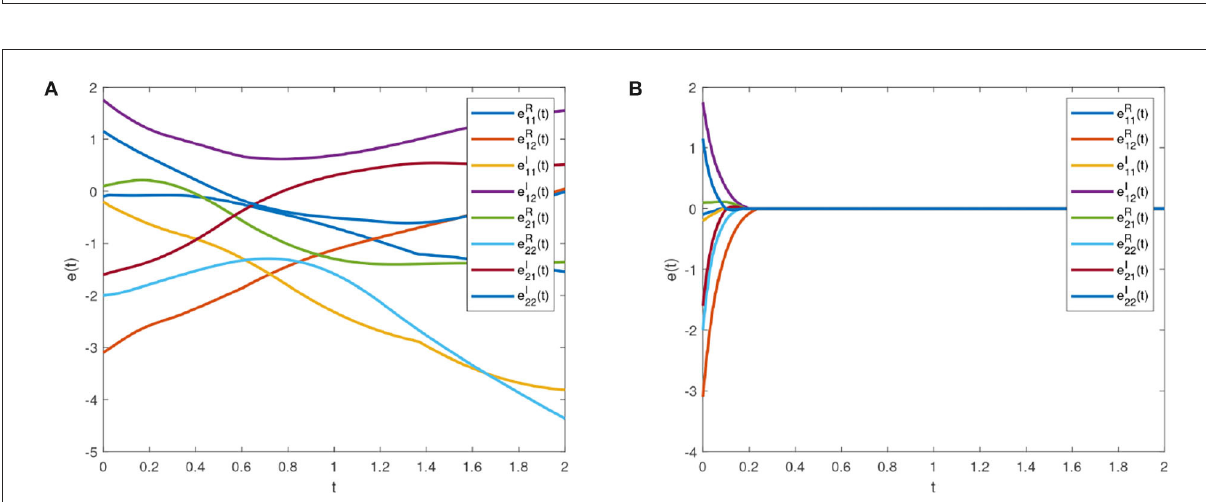
FIGURE5 Error system trajectories of the drive system (16) and response system (17). (A) Synchronization errors without control. (B) Synchronization errors under